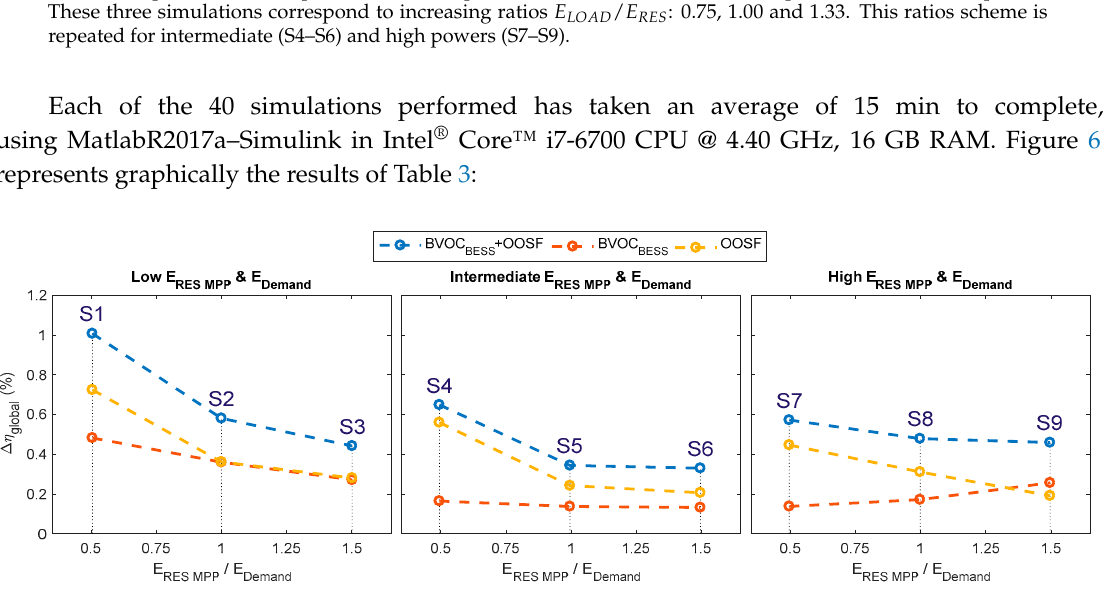
Optimization Δ η : Efficiency improvement over reference E-CBS BVOC BESS + 0.608% OOSF S0 represents the operation of the MG scheduling failures in RES, BESS and INV. This permits to verify that the optimized control system responds correctly to failures and rapid changes. S0 is analyzed in the next sub-section. S1, S2 and S3 represent the MG operation when the power of all the elements is low (compared to their nominal power). These three simulations correspond to increasing ratios E LOAD / E RES : 0.75, 1.00 and 1.33. This ratios scheme is repeated for intermediate (S4–S6) and high powers (S7–S9).